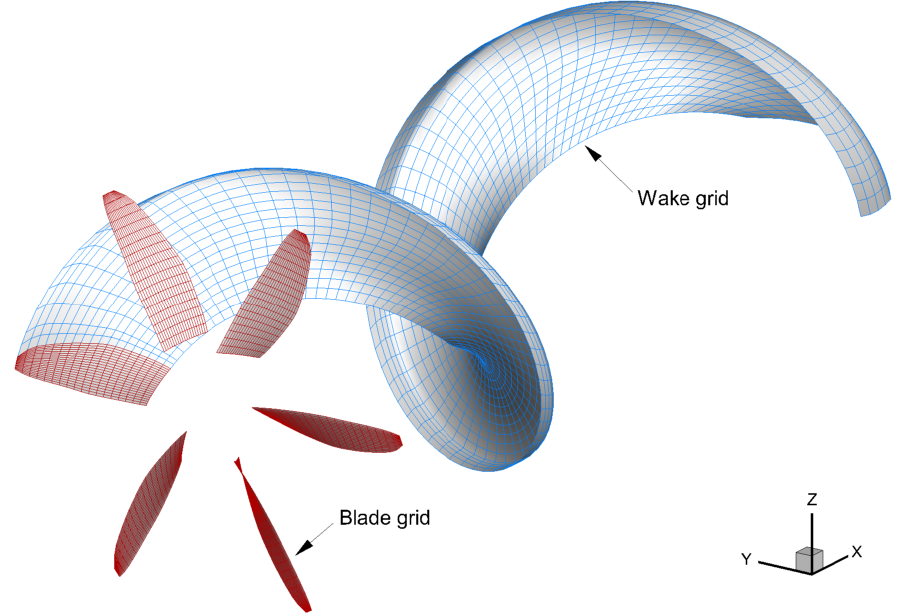
Figure 4. VLM grids for predicting the propeller’s aerodynamic performance.